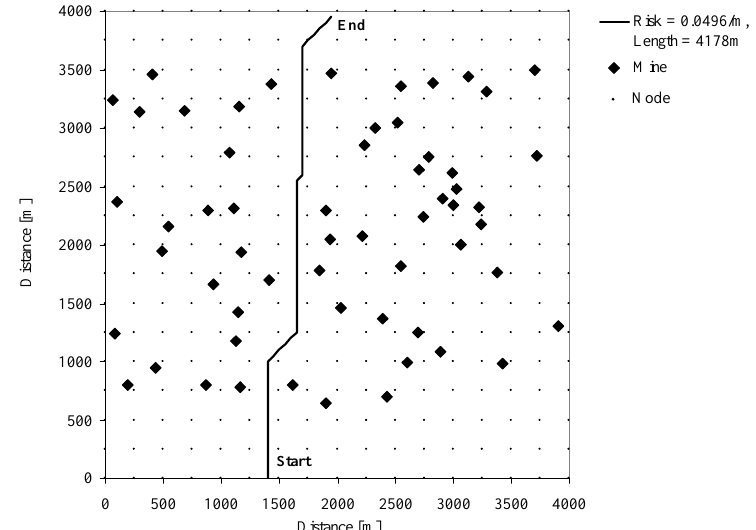
Figure 7: Routes for risk weighting setting = 9%, grid spacing = 50m, safety radius = 0m (for clarity only every fifth grid point is shown).